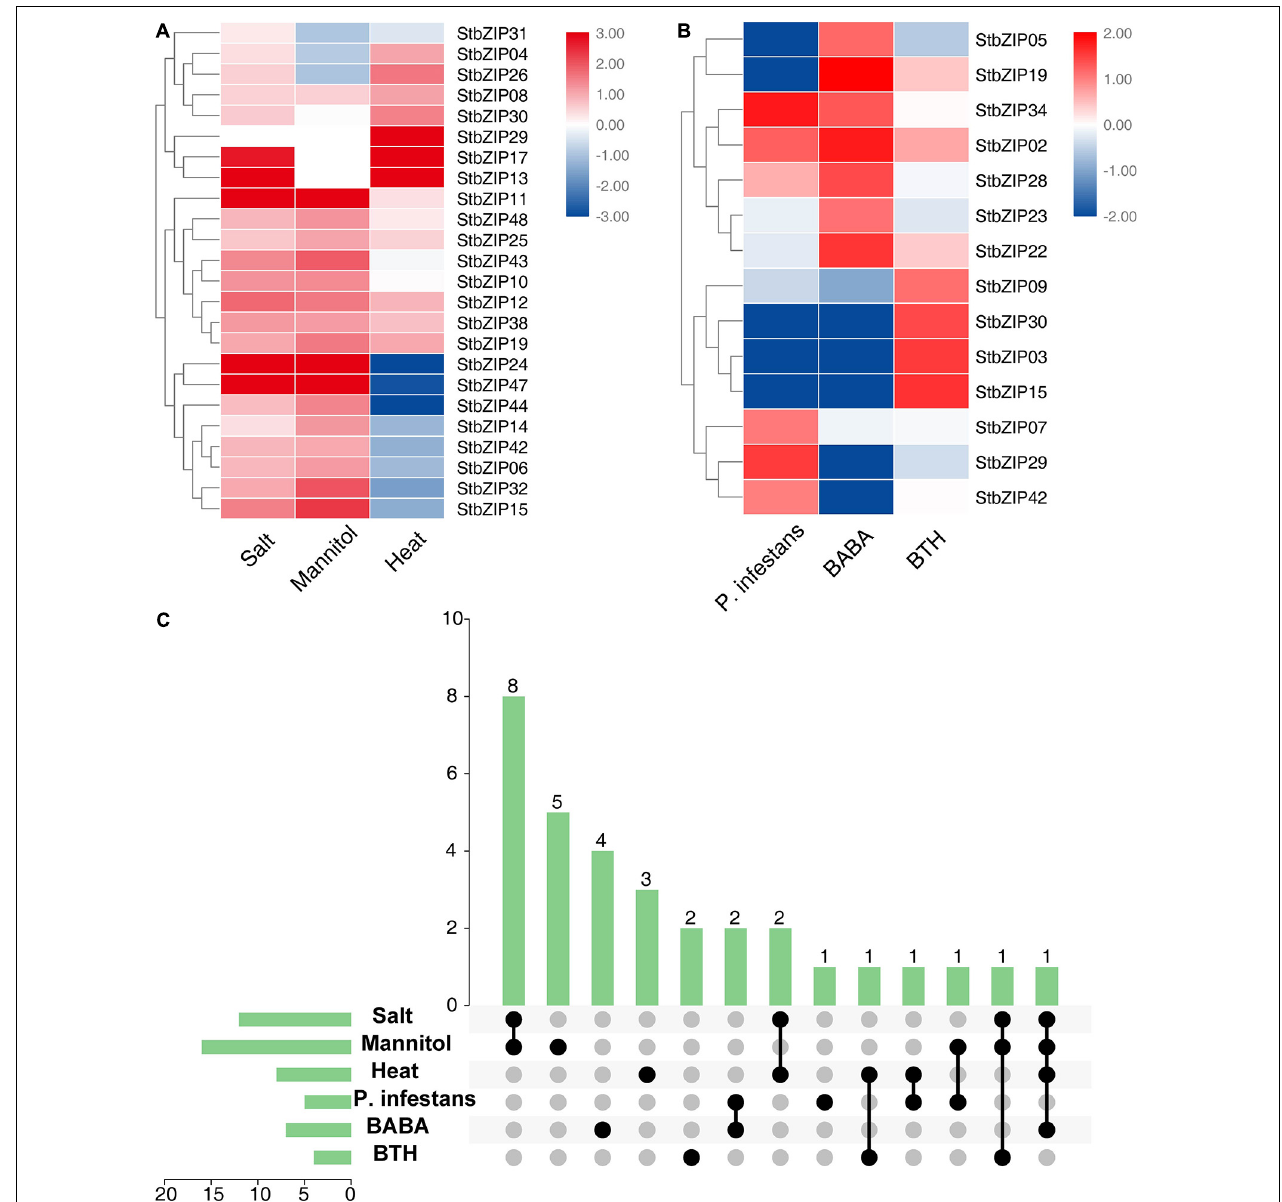
FIGURE 7 | The expression patterns of StbZIP genes under abiotic and biotic stress treatments. (A) Relative expression ratios of the abiotic stress treatments. (B) Relative expression ratios of the biotic stress treatments. (C) Summarized information of the stress-induced StbZIP genes. The relative expression ratios of the abiotic and biotic stress treatments were calculated relative to the untreated control and then the significantly induced gene was defined to possess a log2 relative expression ratio ≥ 1 under one of the stress treatments. The red, white, and blue colors represent the upregulated, unaltered, and downregulated expressions, respectively. The vertical axis and vertical bars represent the number of genes responding to stresses. The points represent the number of genes responding to one or more stresses.